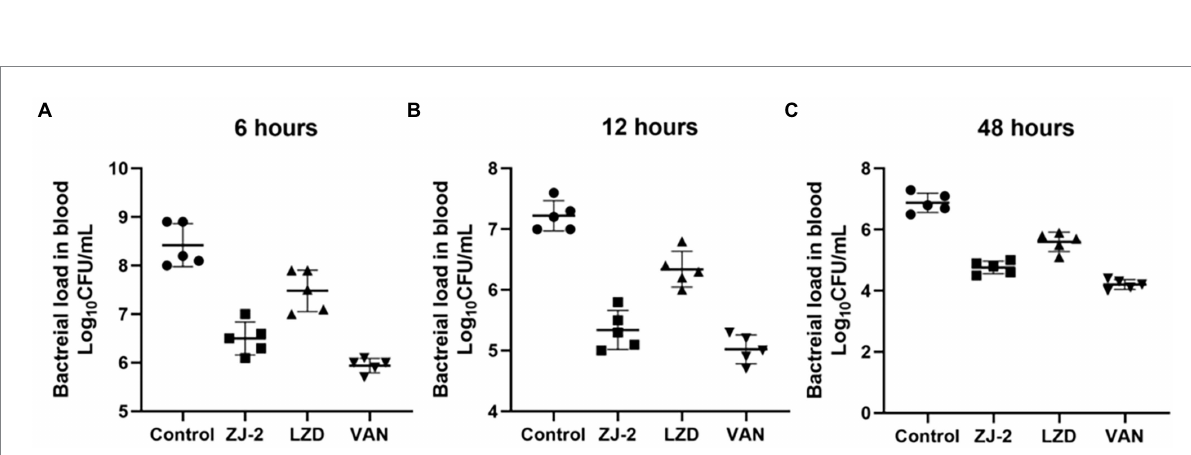
FIGURE 8 Effect of treatment with ZJ-2 on bacterial load in the blood at 6 h (A) , 12 h (B) , and 48 h (C) against E. faecium E3101. Each symbol represents the viable bacterial counts determined in each animal, and the horizontal lines represent the average value for each group. Each OD point presented is the average values of 5